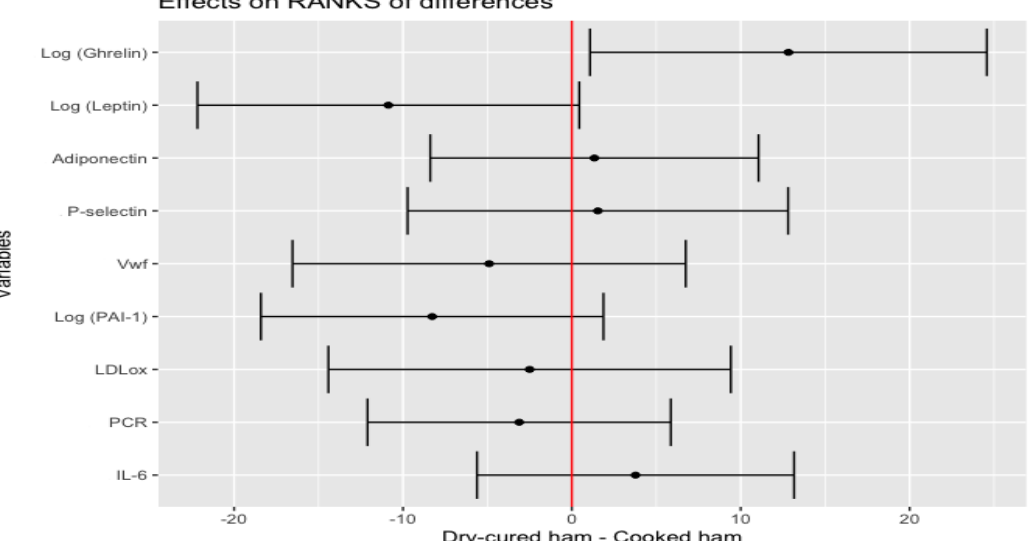
Figure 4. Estimate of the mean range of the effect of the dry-cured ham intake minus the placebo- control product and its 95% confidence intervals for biomarkers of the CV pathophysiological status.